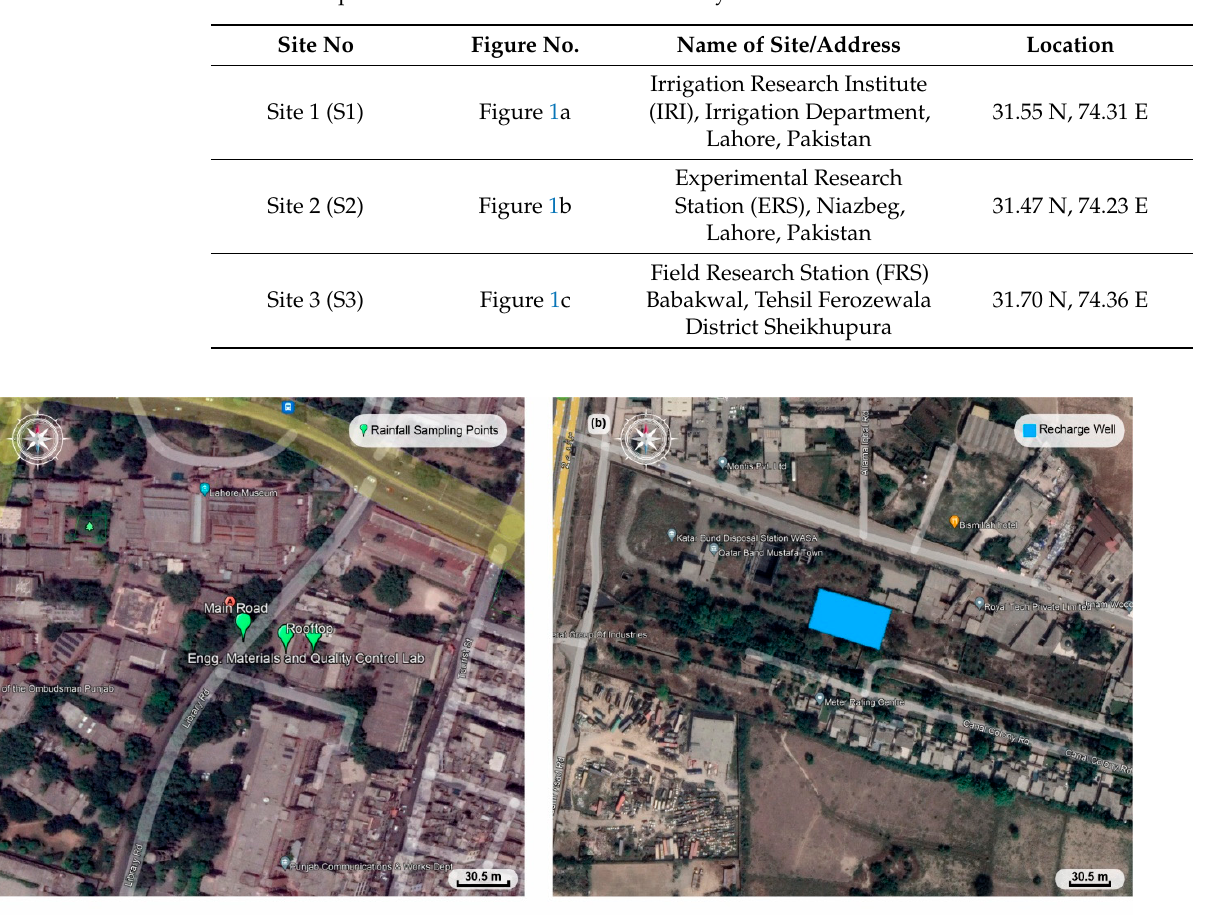
Table 1. Sample collection site locations in the study area.